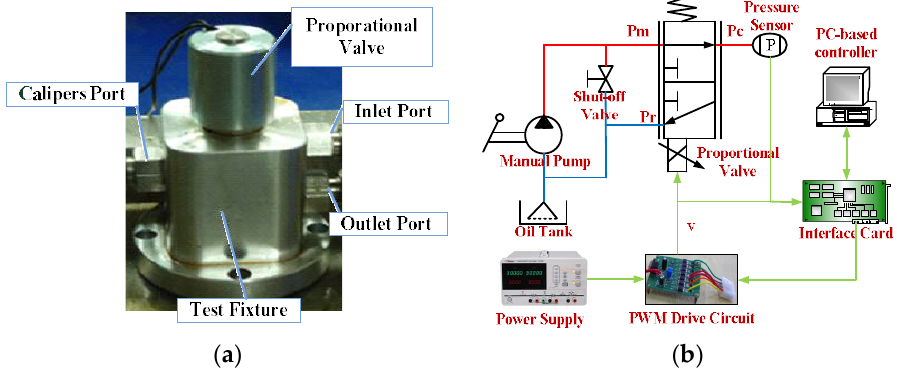
Figure 19. Configuration of single proportional valve test: ( a ) test rig; and ( b ) structure.